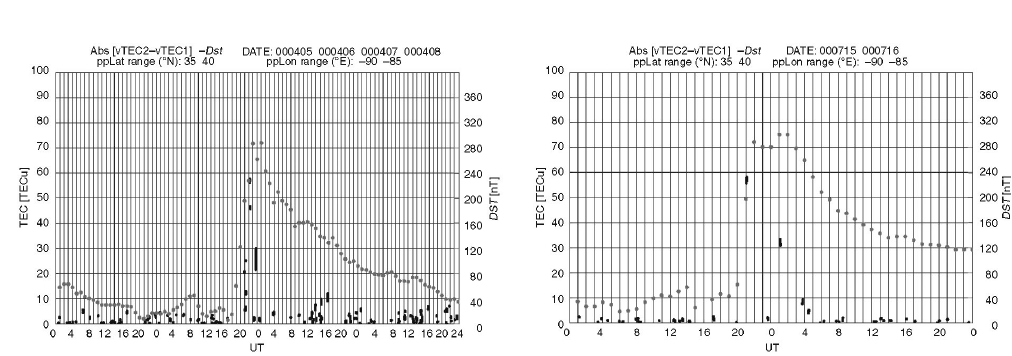
Fig. 18.5. ∆ TEC quantities and – Dst index values as a function of UT for April 05-08 and for July 15-16. Here only pierce points lying in the 5° by 5° region (35°N, 40°N) and (–90°E, –85°E) were